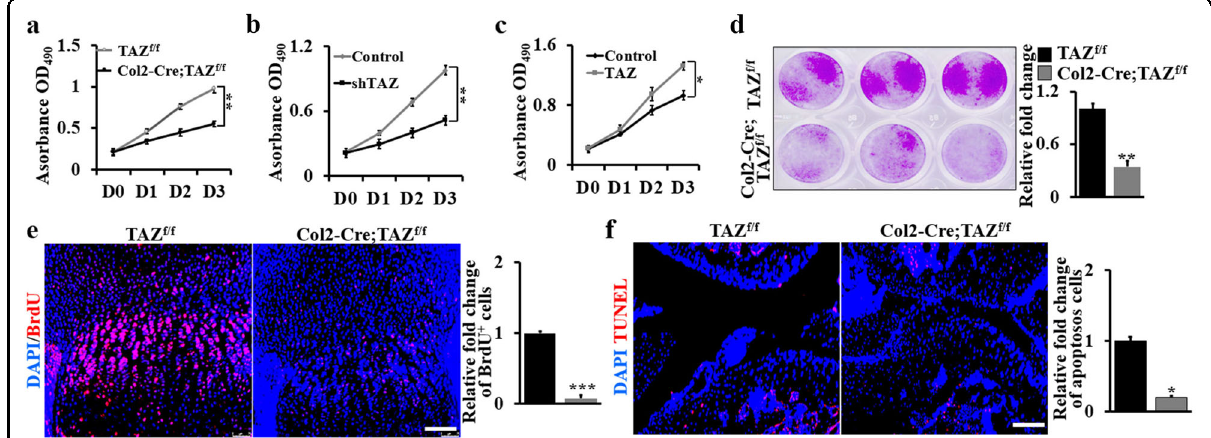
Fig. 4 TAZ is required for chondroprogenitor cell proliferation. a Cell proliferation rate of chondrocytes from Col2-Cre;TAZ f/f mice and controls as shown by WST-1 assay after D0, D1, D2, and D3. b WST-1 assay of chondrocytes with shTAZ lentivirus for different periods of time as indicated. c WST- 1 assay of chondrocytes with TAZ overexpression for different periods of time as indicated. d Colony formation assay using primary chondrocytes from Col2-Cre;TAZ f/f mice and controls. The corresponding quantitative analysis was performed at right. e Fluorescence images of BrdU + in the tibiae from Col2-Cre;TAZ f/f mice and controls at P10. The BrdU + cells are quanti fi ed in the corresponding column at right. Scale bars, 75 μ m. f TUNEL staining and quantitative analysis of the apoptosis-positive cell in the region of the articular cartilage at age of 1-month Col2-Cre;TAZ f/f mice and controls. The apoptosis-positive cells are quanti fi ed in the corresponding column at right. Scale bars, 75 μ m. The experiment was independently repeated for three times. Error bars were the means ± SEM of triplicates from a representative experiment. * P < 0.05, ** P < 0.01, *** P <